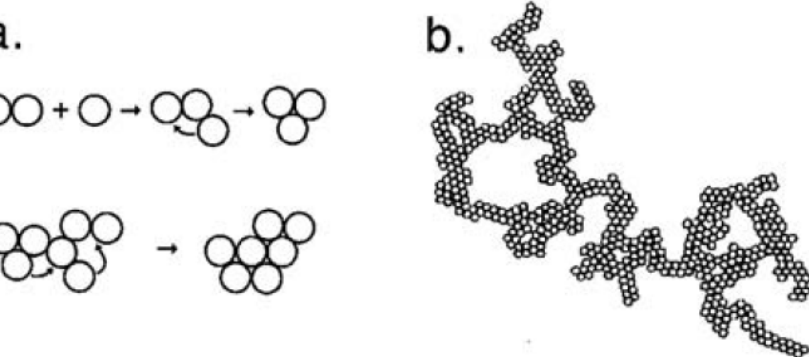
Figure 9. Short-term rearrangement. ( a ) Particle rearrangement. ( b ) Fractal group in two dimensions, where a short-term rearrangement has occurred. Reproduced with permission from [Walstra, P.], [ Physical Chemistry of Foods ]; published by [Marcel Dekker],